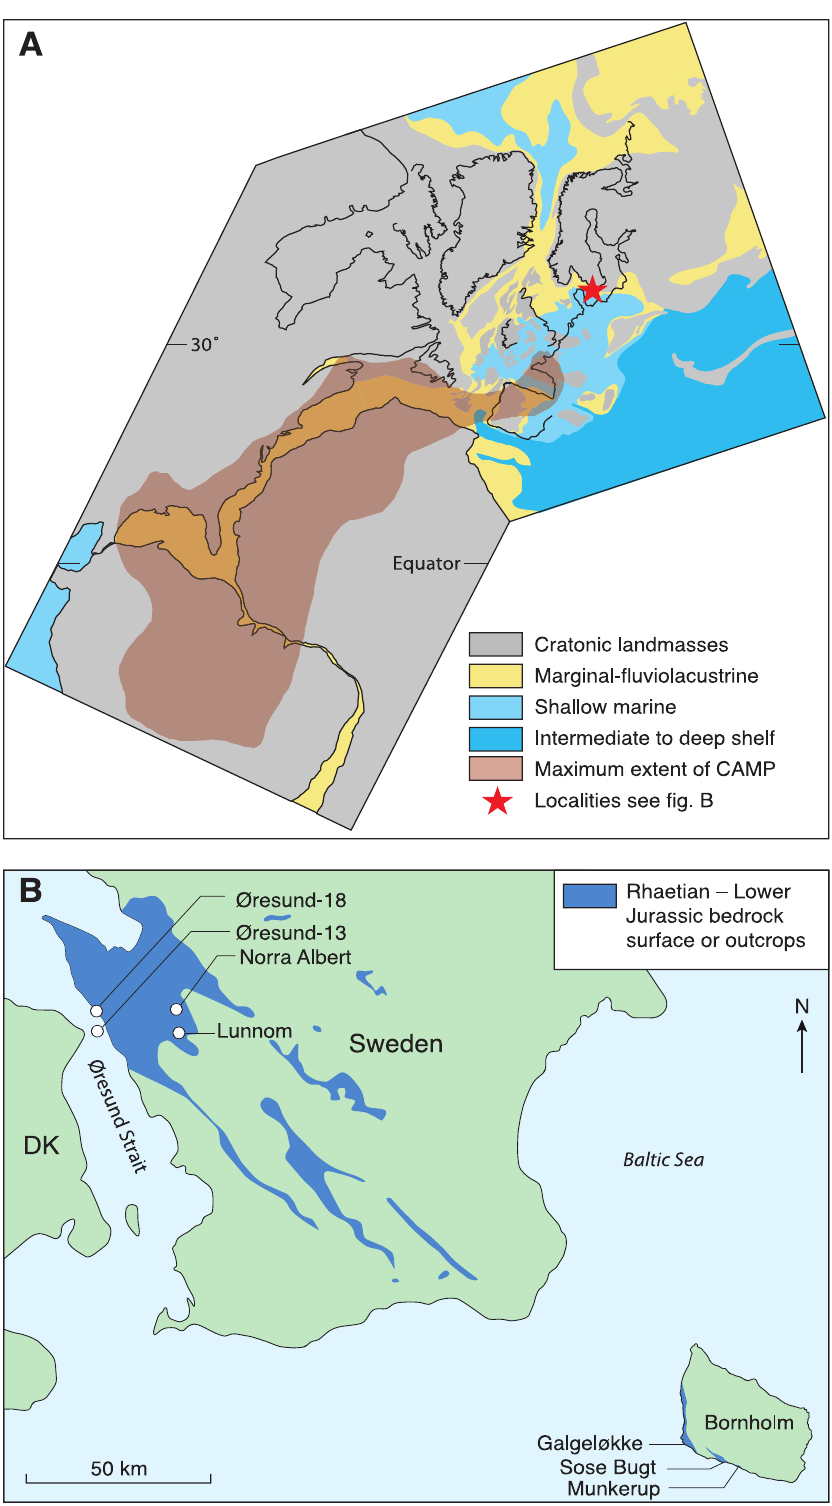
Figure 1. Palaeogeography at the Triassic–Jurassic boundary and location of the study area and investigated coal/coaly beds. A Palaeogeographic reconstruction of central Pangea showing the maximum extent of the Central Atlantic Magmatic Province (CAMP) (Modified after [7]). The location of the study area in the Danish Basin is marked by a red star. B Close up map of the study area, showing the localities/wells containing the investigated coal/coaly beds: Lunnom (Rhaetian, B-bed), Norra Albert (Rhaetian, B- and A-bed), Munkerup Member (lowermost Hettangian), Øresund-13 (lower Hettangian), Sose Bugt (uppermost Hettangian, D-bed; lowermost Sinemurian, B-bed), Øresund-18 (Sinemurian), and Galgeløkke (upper Sinemurian). DK = Denmark.